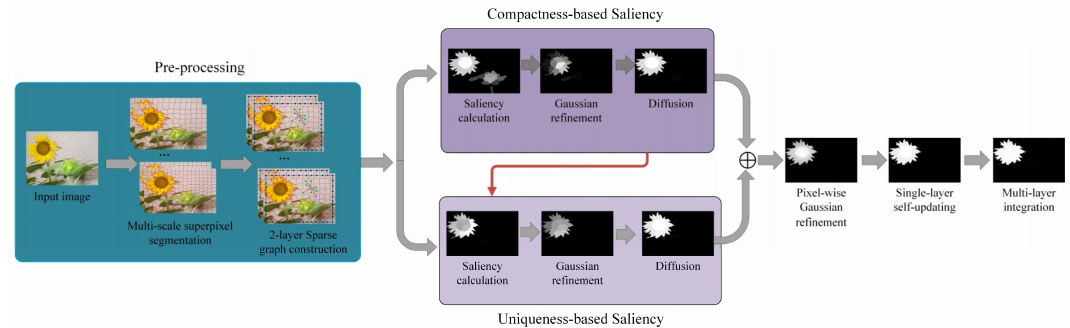
Figure 3. Main steps of the proposed